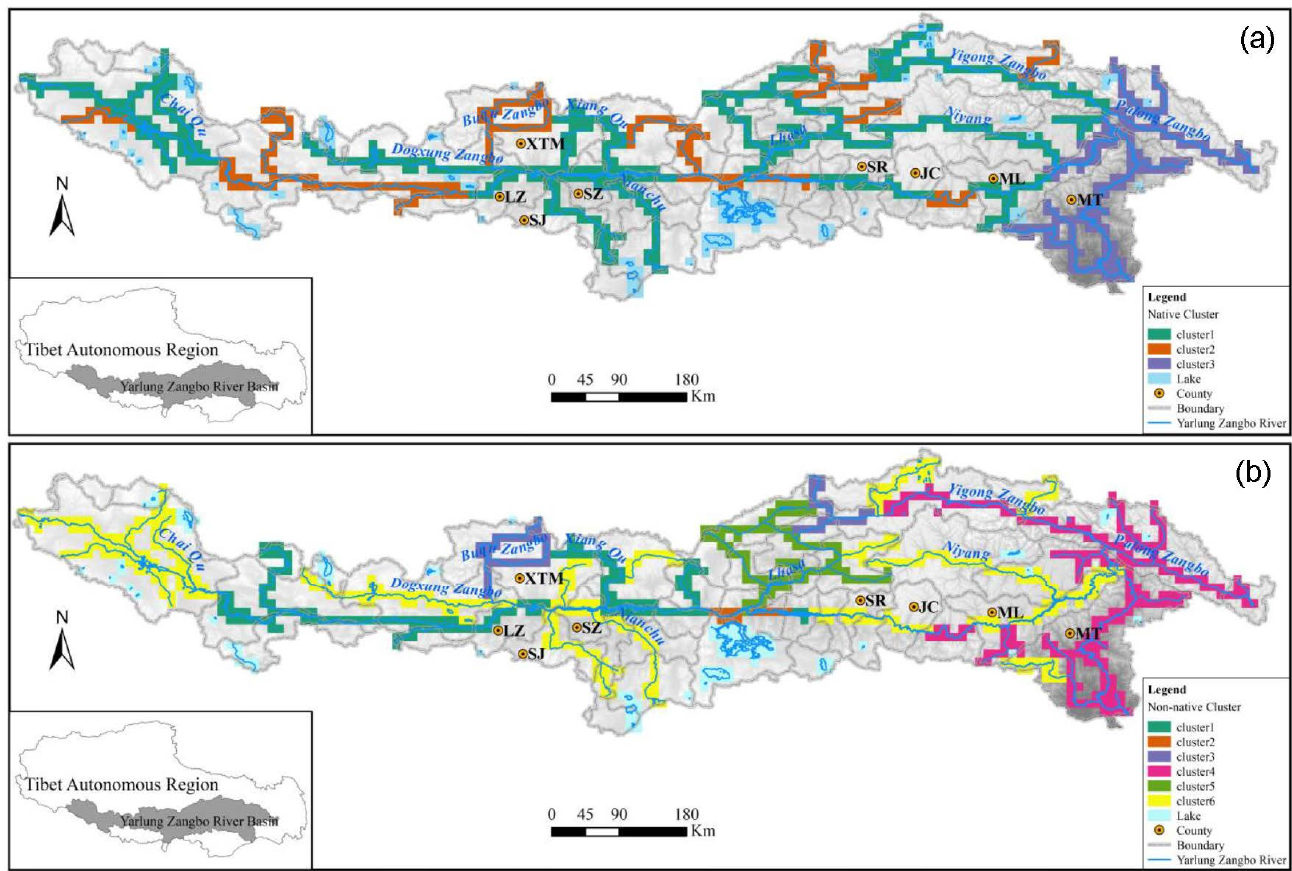
Figure 4. Native and non-native fish distributions in the Yarlung Zangbo River. ( a ) The three clusters on the native fish distribution map. ( b ) The six clusters on the non-native fish distribution map.